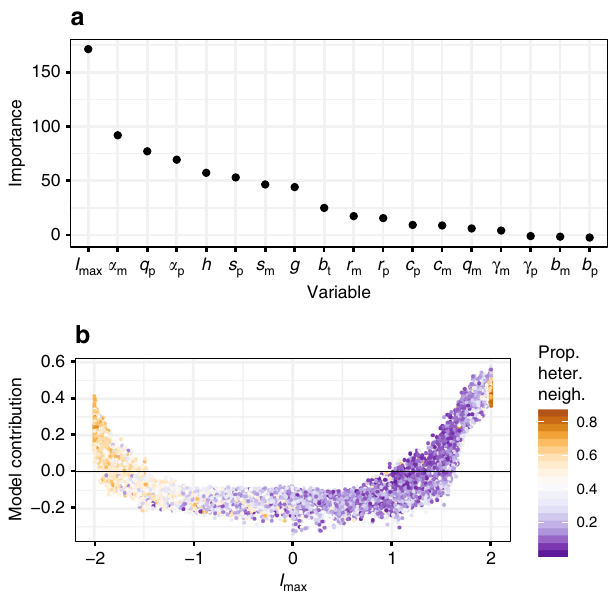
Fig. 5 Predictors of plant coexistence according to random forest. Results from a random forest classi fi er using each variable (including maximum net PSF value, I max ) to predict whether all fi ve species coexist until the end of the simulation. a Importance of each variable in predicting plant diversity maintenance, where importance is the mean decrease in the model ’ s classi fi cation accuracy when a variable is permuted (normalized by the standard deviation). b Conditional feature contribution of PSF strength to plant diversity. Each point represents the relative contribution of I max to the predicted value of plant diversity of an independent model run. A model contribution value >0 means that the feedback value for that run contributes positively to the prediction of species coexistence. Point colours indicate the proportion of heterospeci fi c neighbours for each tree at the end of the run. A value of zero represents a forest dominated by one species (100% conspeci fi c neighbours), and a value of 1 means that no two adjacent plants are of the same species. Panel ( b ) shows that negative feedback maintains diversity, and is associated with spatial dispersion of plants. Strong positive feedback can also maintain diversity by reducing species turnover, but this represents an extreme case unlikely to be stable through time. See Supplementary Fig. 2 for the conditional feature contributions of every simulation parameters to (1) the maintenance of plant species diversity, (2) the development of strong negative PSF, and (3) a correlation between host abundance and PSF. The fi rst random forest (accuracy = 0.88, precision = 0.87, recall = 0.71) identi fi ed plant-soil feedback strength (de fi ned in Eq. (6)) as the primary determinant of plant diversity maintenance (Fig. 5, Supplemen- tary Fig. 2). According to the random forest feature contribution plot, strong negative and positive feedback are both associated with the maintenance of diversity over the course of the simu- lation; strong negative feedback tends to generate more even spatial distributions of plants, while positive feedback is asso- ciated with strong spatial aggregation (Fig. 5b). Furthermore, plant abundances are much more likely to reach a stable temporal equilibrium under negative feedback than under positive feedback (Supplementary Fig. 3). Thus, the simulation indicates that positive feedback would not maintain diversity inde fi nitely. simulation parameters that determine whether strong negative feedback develops (i.e. whether I max < − 1.5; accuracy = 0.94, precision = 0.79, recall = 0.92). The strongest predictor of